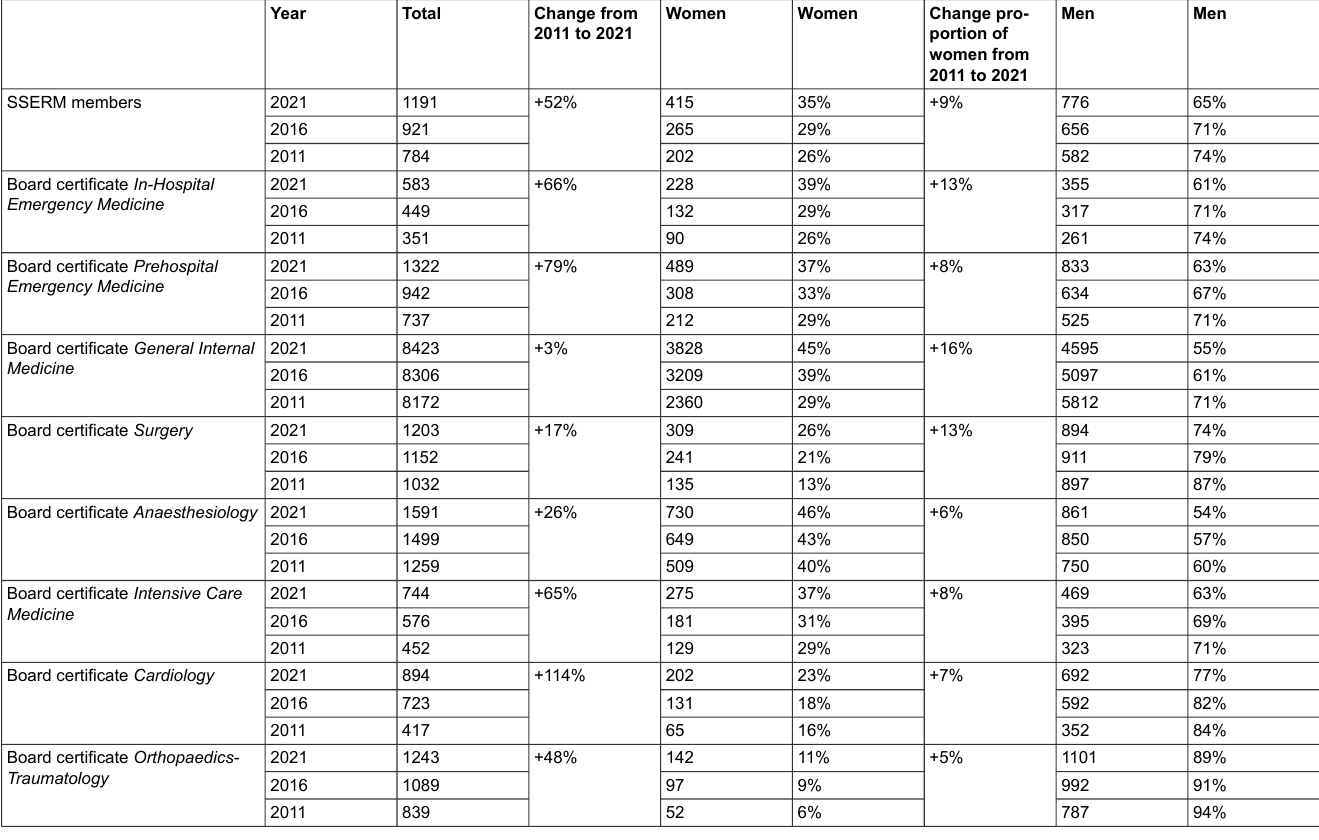
Table 1: Physicians by board certification and gender in 2011, 2016 and 2021 in Switzerland.